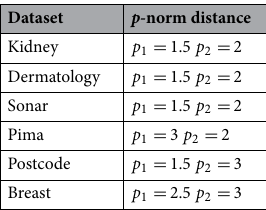
Table 7. The p -norm distance setting in different datasets.